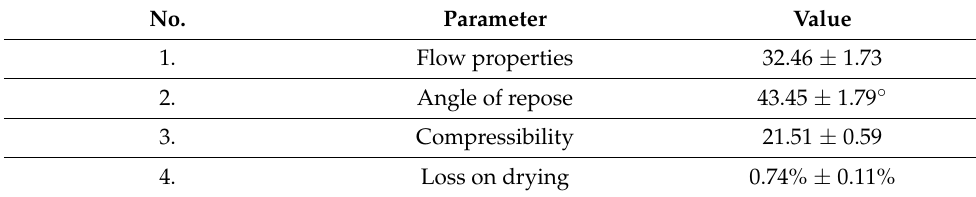
Table 5. Physical properties of mangosteen peel extract